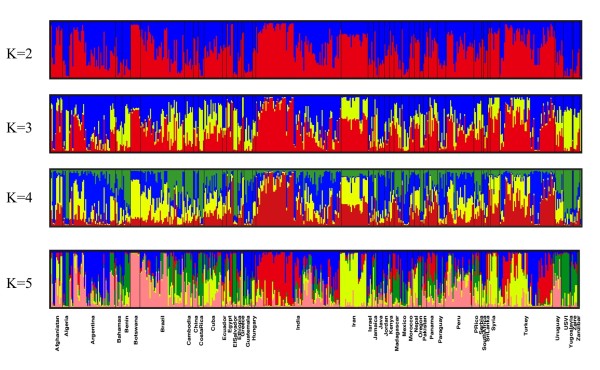
Clustering of samples (n = 488) from program Structure where samples are displayed based on country of origin. Values of K (number of clusters) ranged from 2 to 5. The most supported model was K = 5; models with lower K values are shown to demonstrate progression of groupings.